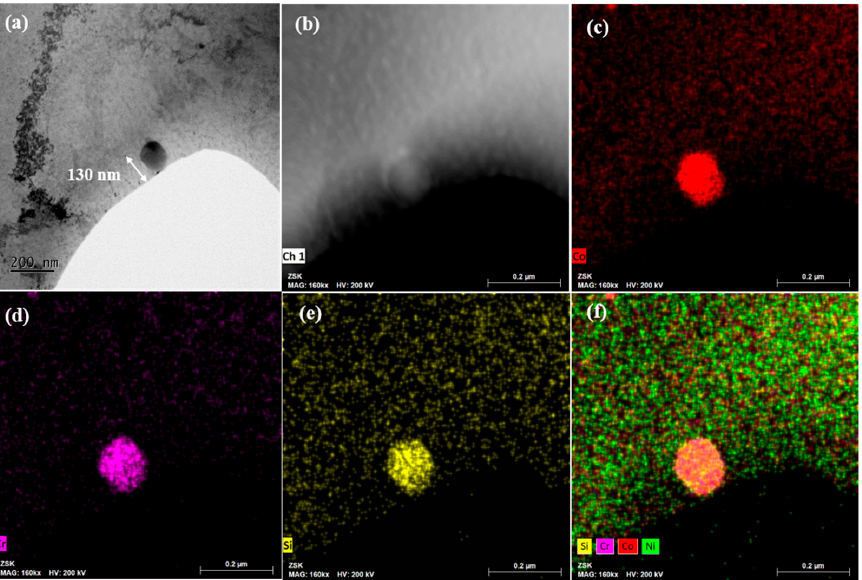
Figure 4. Bright-field TEM image and EDS map. ( a ) Bright field image of large particles. ( b – f ) EDS mapping of different elements in the large particles.